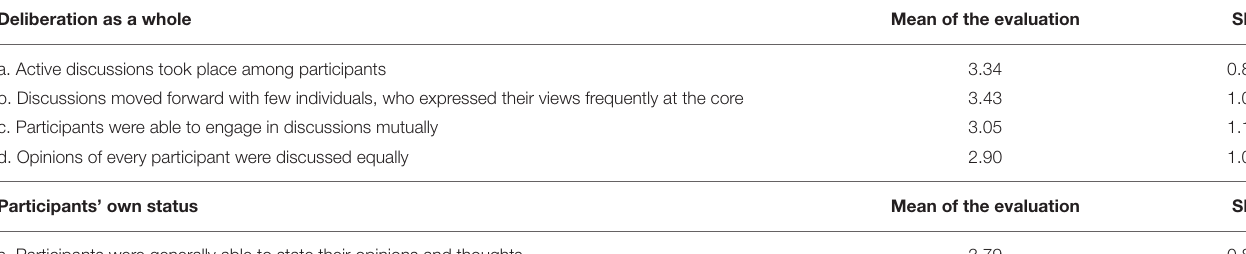
TABLE 10 | Evaluation of the online